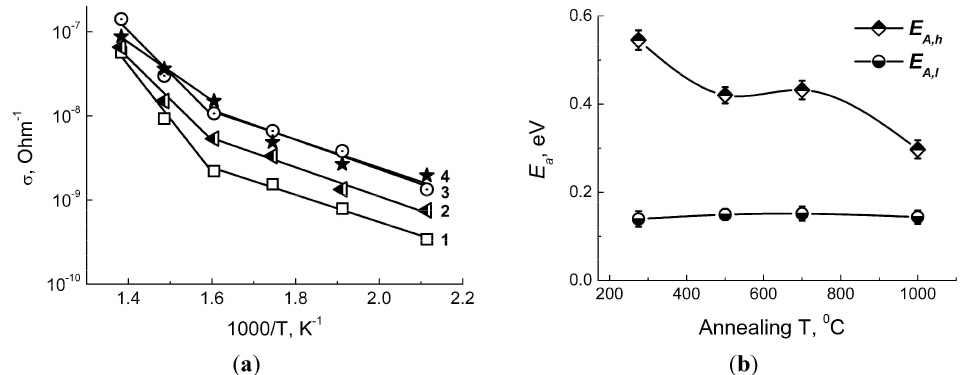
Figure 4. ( a ) Temperature dependence of DC-conductance ( σ ) of BaSnO